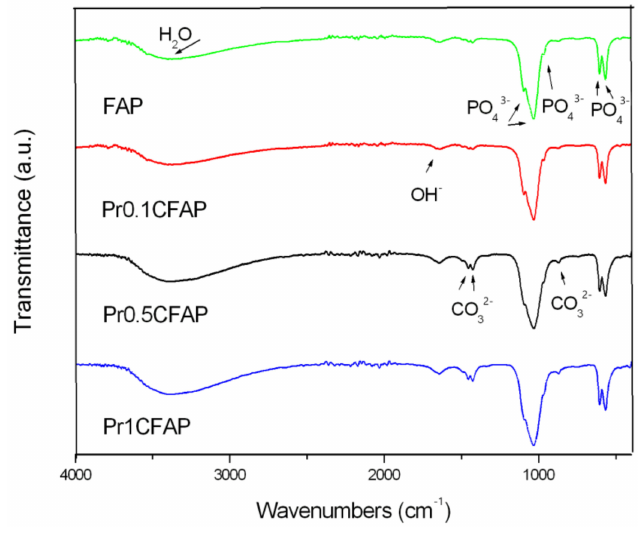
Figure 2. FTIR transmittance spectra of the FAP and Pr x CFAP samples. Table 2. FTIR vibration bands for FAP and PrxCFAP